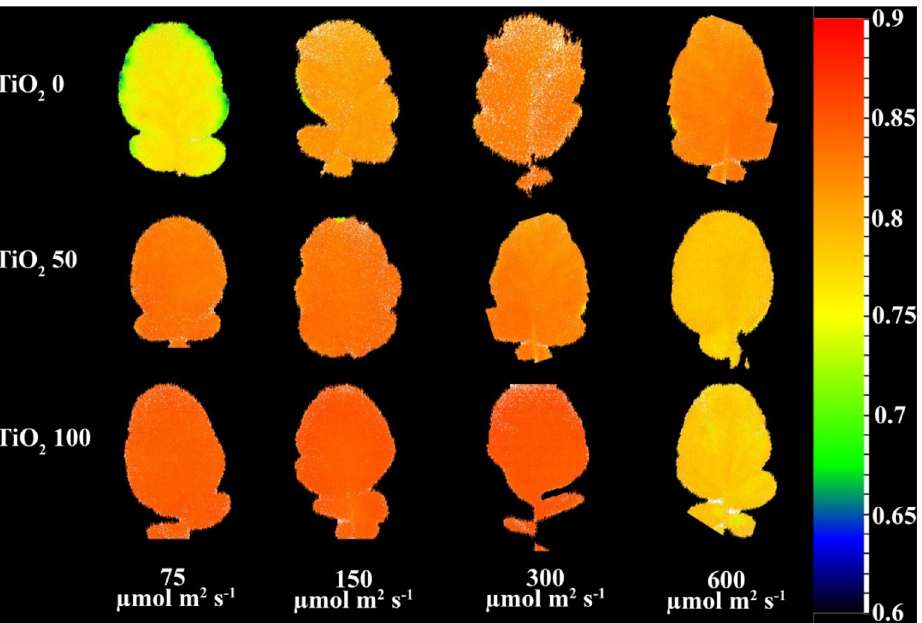
Figure 6. Representative image of the maximal quantum yield of PSII photochemistry (F v /F m ) (equation and explanation in Table 3) of radish cv. Cherry belle plants cultivated under different light intensities (75, 150, 300 and 600 µmol m −2 s −1 ) and sprayed (once a week, and three times in total) with titanium dioxide (TiO 2 ) nanoparticles at different concentrations (0, 50 and 100 µmol L −1